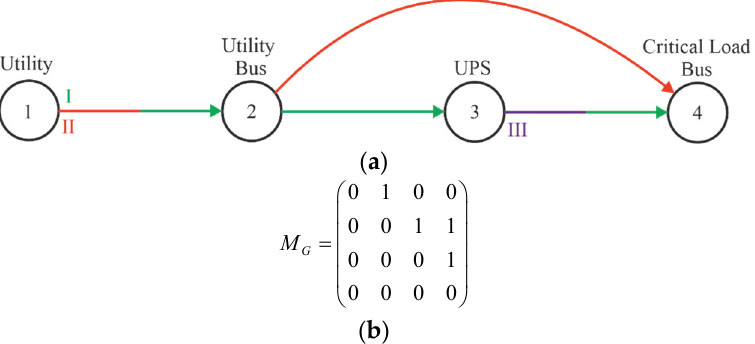
Figure 7. Configuration of Single System: ( a ) Oriented graph; ( b ) Adjacency matrix.